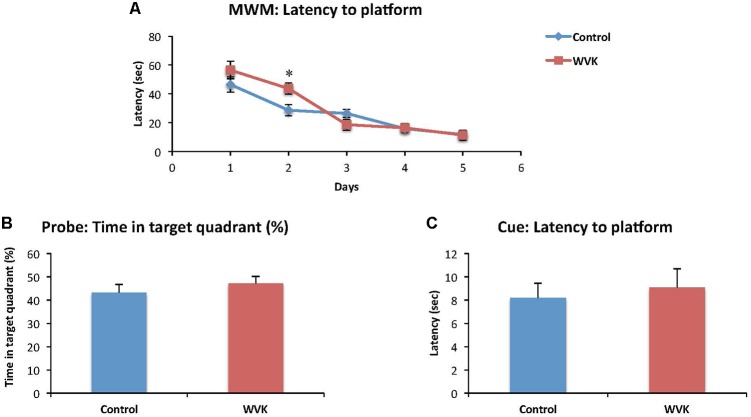
Effect of WVK treatment on spatial learning, memory retention, and cue test in the Morris water maze. Figures show (A) the mean latency (s) to reach the submerged platform over the 5-day test; (B) the percentage (%) of time spent in the target quadrant with platform removed; (C) the mean latency (s) to reach the visible platform. Values are mean ± SEM, n = 8–13 rats per group. Data were analyzed by (A) repeated-measures ANOVA, followed by Bonferroni post hoc test or (B,C) Student’s unpaired t-test. Statistically different between C and WVK groups, ∗p < 0.05.